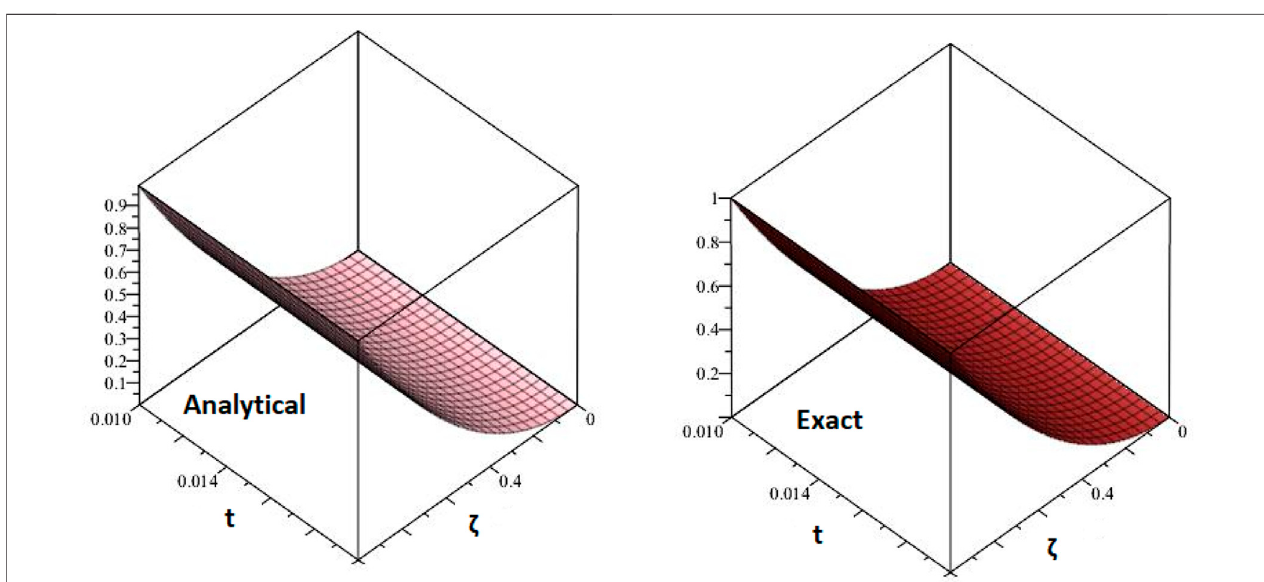
Frontiers in Physics |